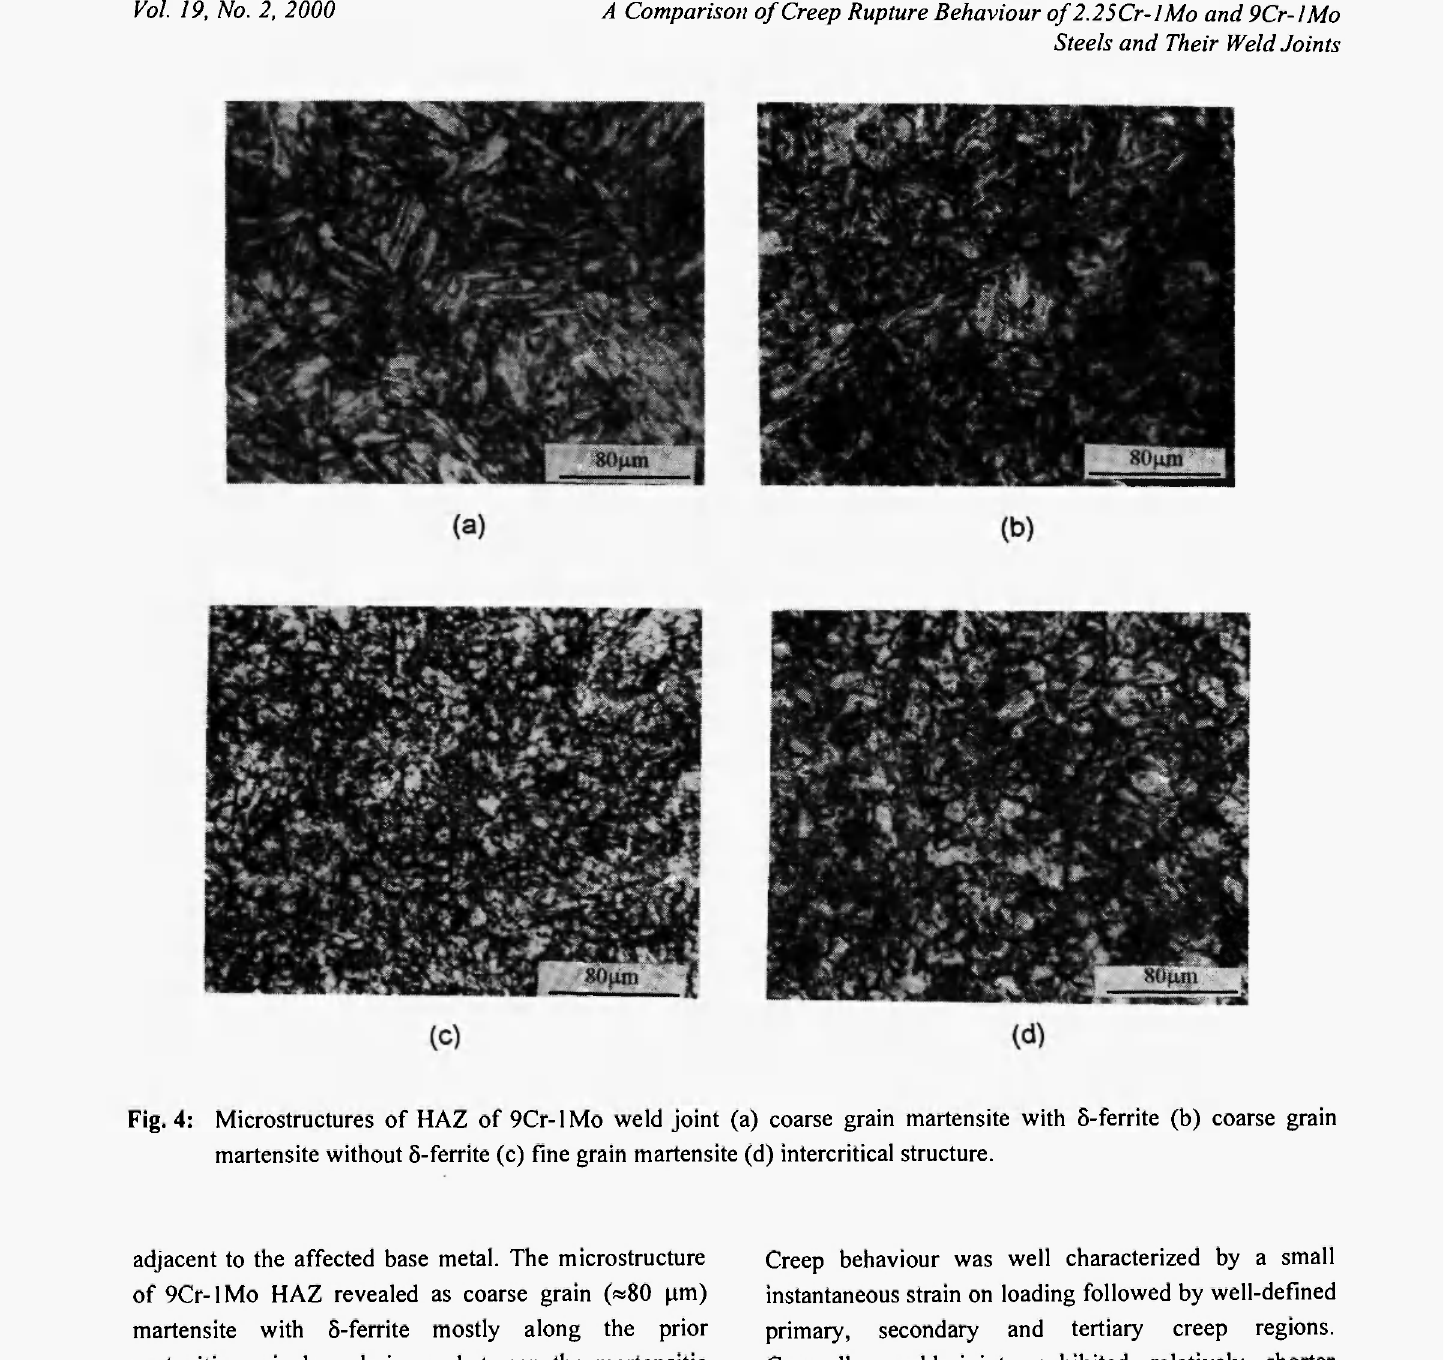
Fig. 4: Microstructures of HAZ of 9Cr-lMo weld joint (a) coarse grain martensite with δ-ferrite (b) coarse grain martensite without δ-ferrite (c) fine grain martensite (d) intercritical